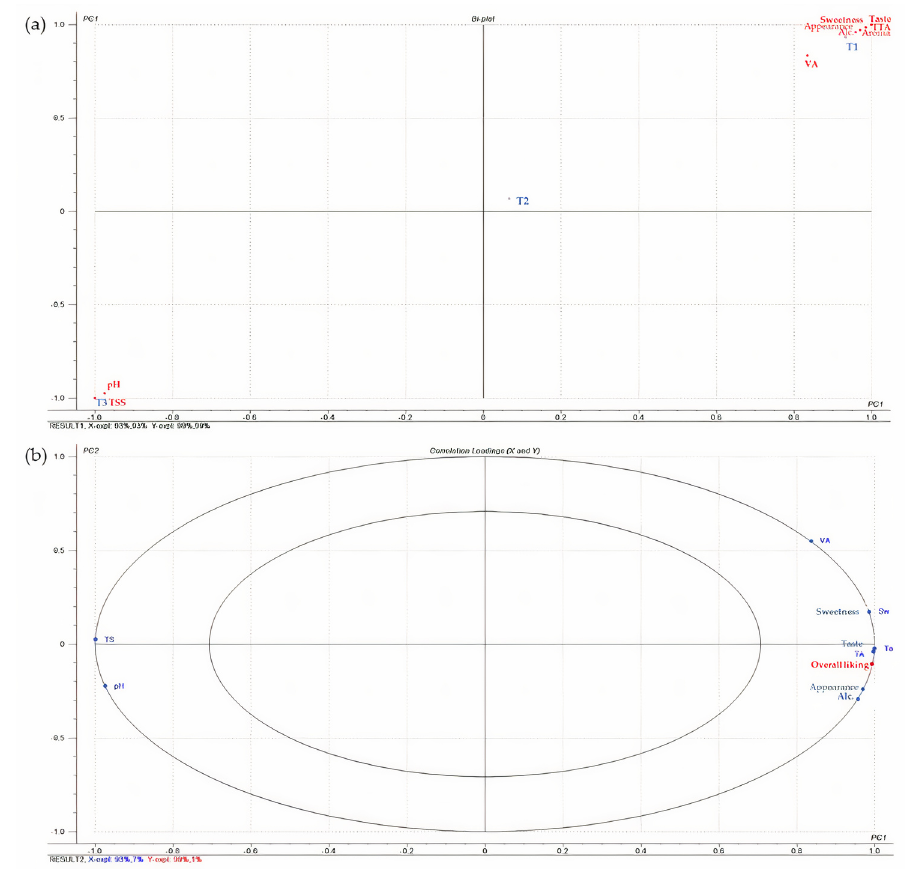
Figure 3. The PCR biplot of scores and X-loadings for the pineapple wine data ( a ) and the correlation between physicochemical and sensory variables and an overall liking variable ( b